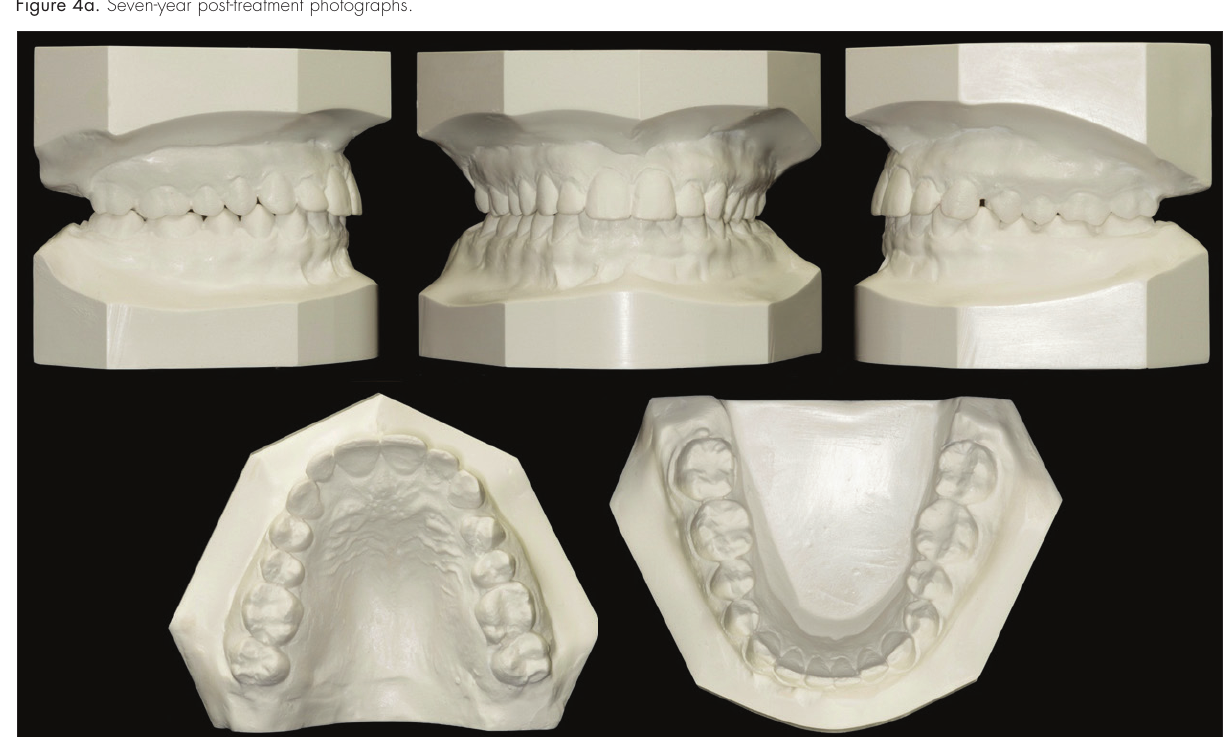
Figure 4b. Seven-year post-treatment study